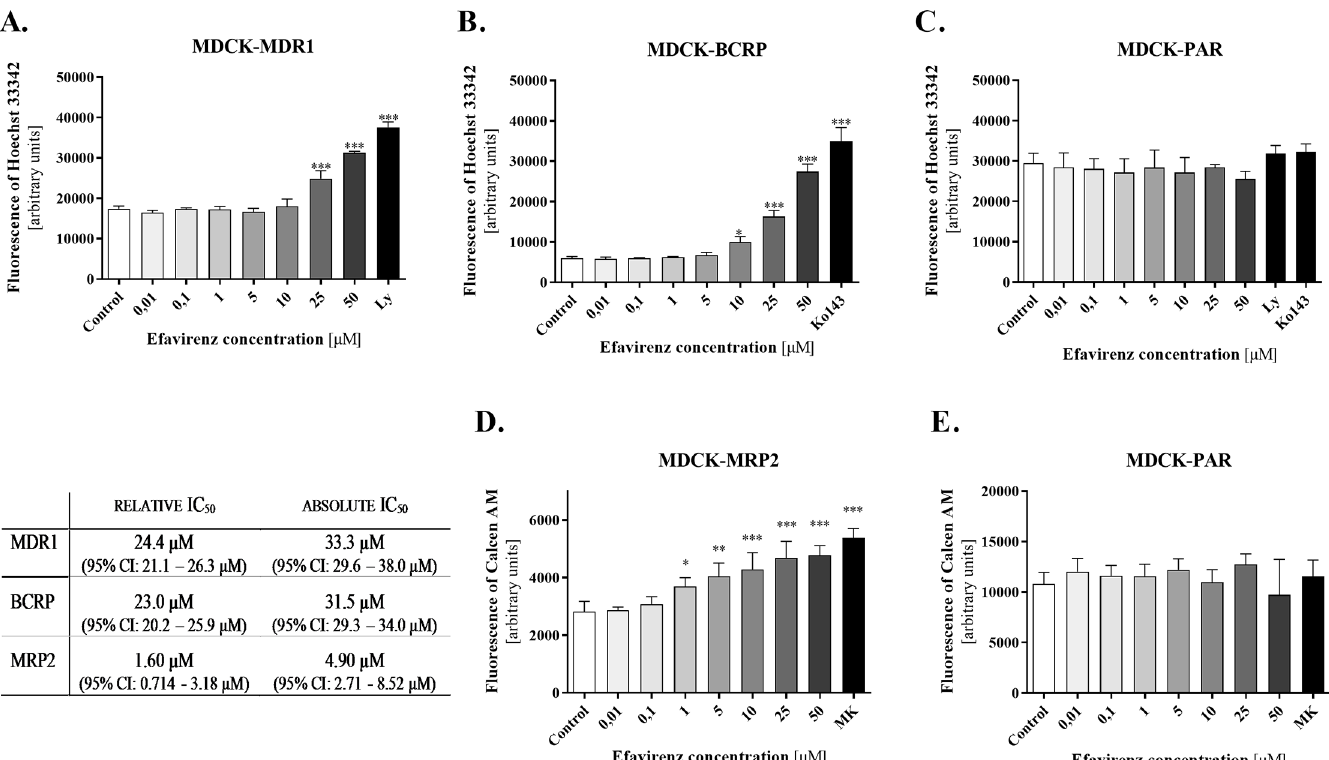
Fig 3. Inhibitory effect of efavirenz on MDR1, BCRP, and MRP2 transporters. Efavirenz was applied at concentrations of 0.01–50 μ M to evaluate its inhibition of Hoechst 33342 accumulation in the MDCK-MDR1 (A), MDCK-BCRP (B), and parental MDCK (C) cell lines, as well as its inhibition of calcein efflux from the MDCK-MRP2 (D) and parental MDCK (E) lines. Model inhibitors of MDR1, BCRP and MRP2, namely LY335979 (LY, 1 μ M), Ko143 (2.5 μ M), and MK571 (10 μ M), respectively, were used as positive controls at the minimal concentrations causing maximal inhibition in the corresponding cellular system and assay. Relative and absolute IC 50 values were calculated as the concentrations of efavirenz needed to achieve 50% transporter inhibition. The relative IC 50 was determined from the maximum and minimum extremes of the relevant non-linear regression plot showing the inhibitory effect of efavirenz alone (maximal inhibition = 100%, non-inhibited control = 0%). The absolute IC50 was determined from the relevant non-linear regression plot of the inhibitory effect of the control inhibitor (100%) and the accumulation observed in control non-inhibited cells (0%). Data were analyzed by one-way ANOVA followed by Bonferroni’s multiple comparison test ( (cid:3) P (cid:20) 0.05, (cid:3)(cid:3) P (cid:20) 0.01, (cid:3)(cid:3)(cid:3) P (cid:20) 0.001) and are presented as means ± SD of at least three experiments (n = 3–5) performed in